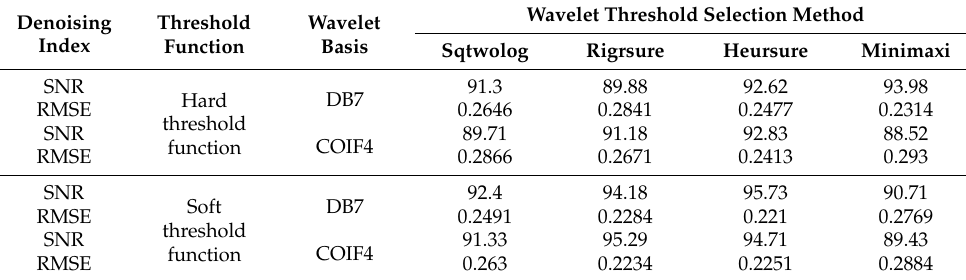
Table 3. Conventional wavelet threshold denoising method.